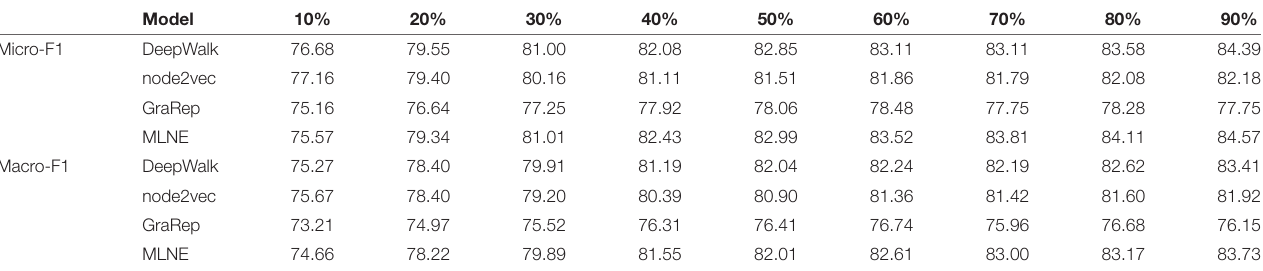
TABLE 2 | Node classification results on Cora. Model